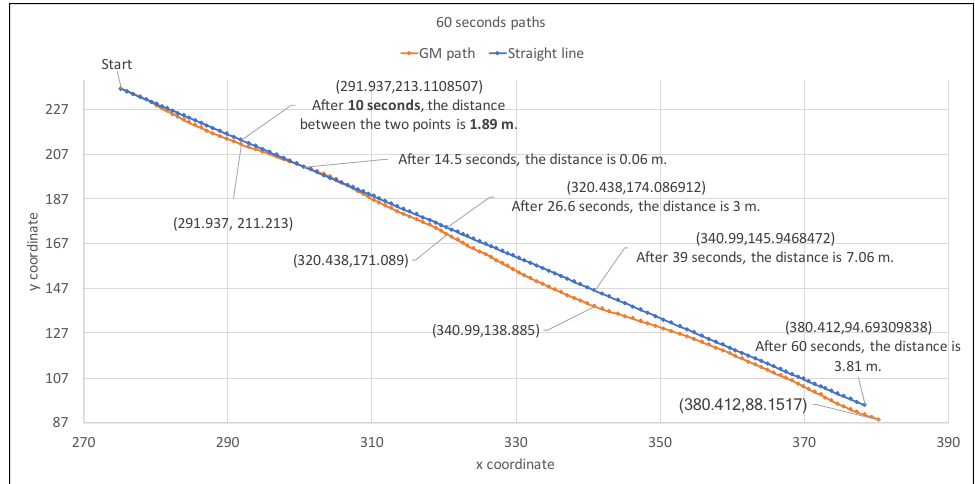
Figure 12. Sample of GM path and the expected straight line path for 60